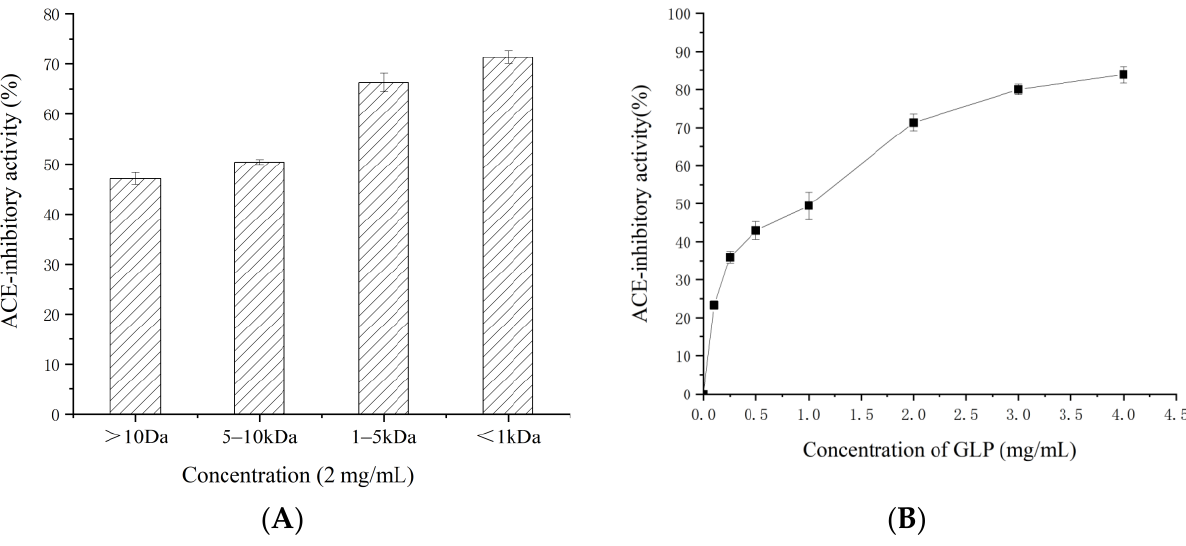
Figure 1. ACE-inhibitory activity of different MW fractions ( A ) and <1 kDa fractions ( B ).